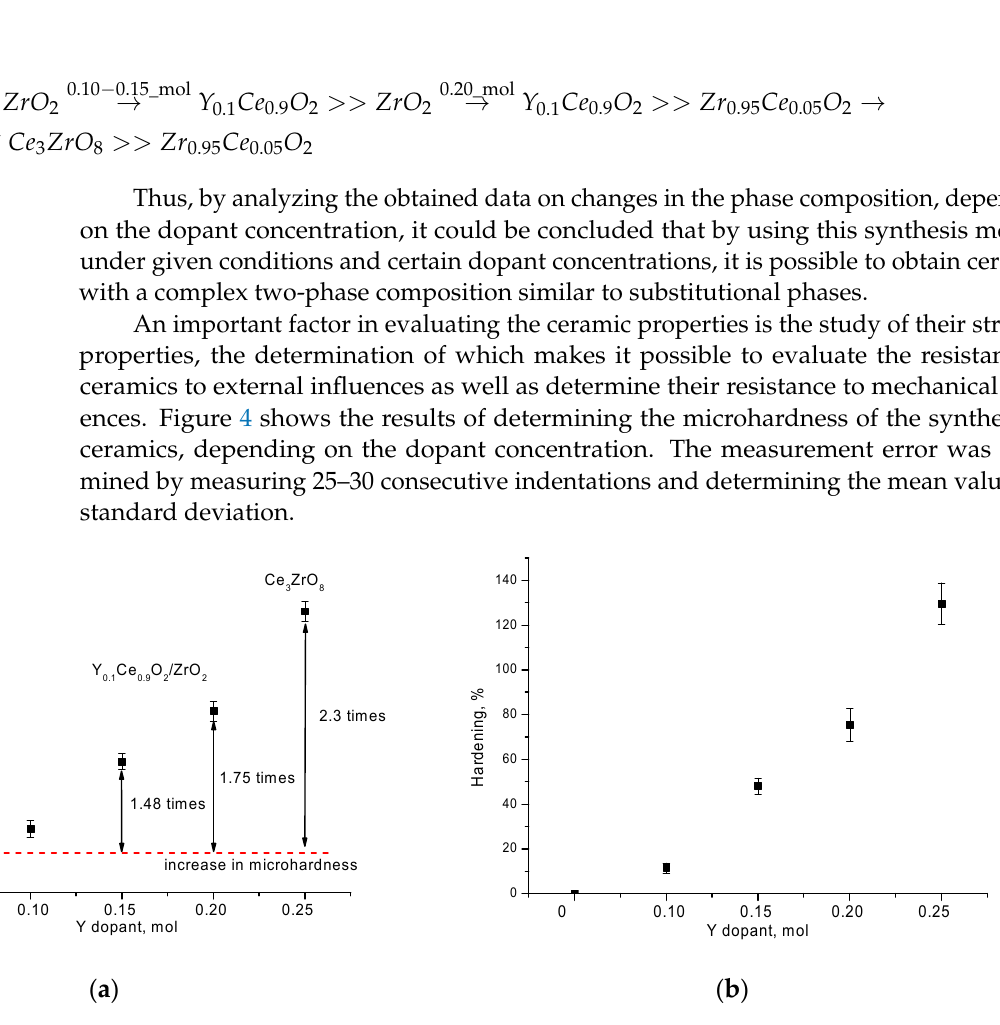
Figure 4. ( a ) The results of changing the value of the microhardness depending on the dopant concentration. ( b ) Results of ceramic hardening, depending on dopant concentration.